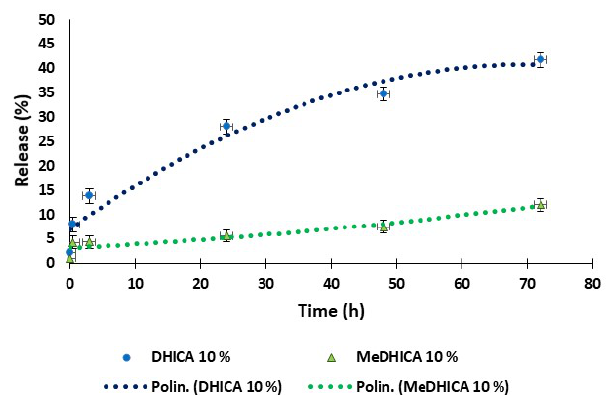
Figure 3. Kinetics of release of DHICA or MeDHICA at 10% w / w from HGel-A in PBS at pH 5.5 with refreshing of the medium over 72 h. Reported are the mean ± SD values of three experiments and the polynomial regression that fits the data.